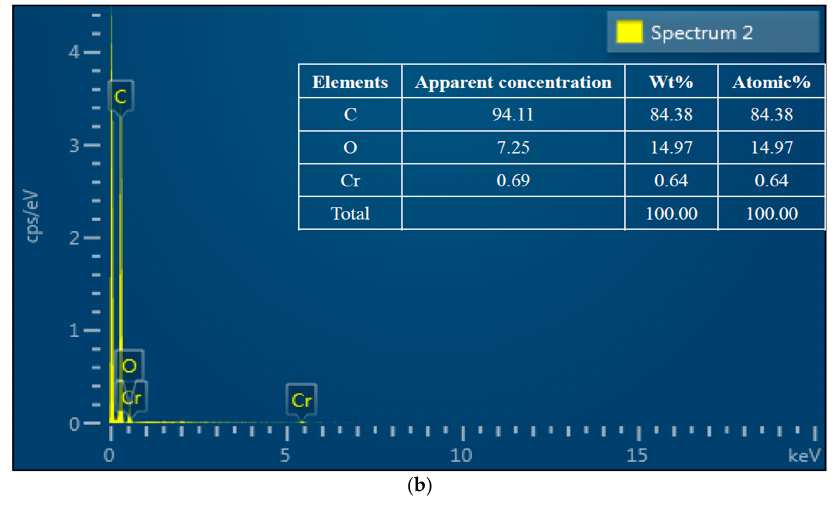
Figure 3. Energy dispersive spectroscopy (EDS) spectra of WPAC (( a , b ) before and after Cr(VI) adsorption, respectively, at pH 3).